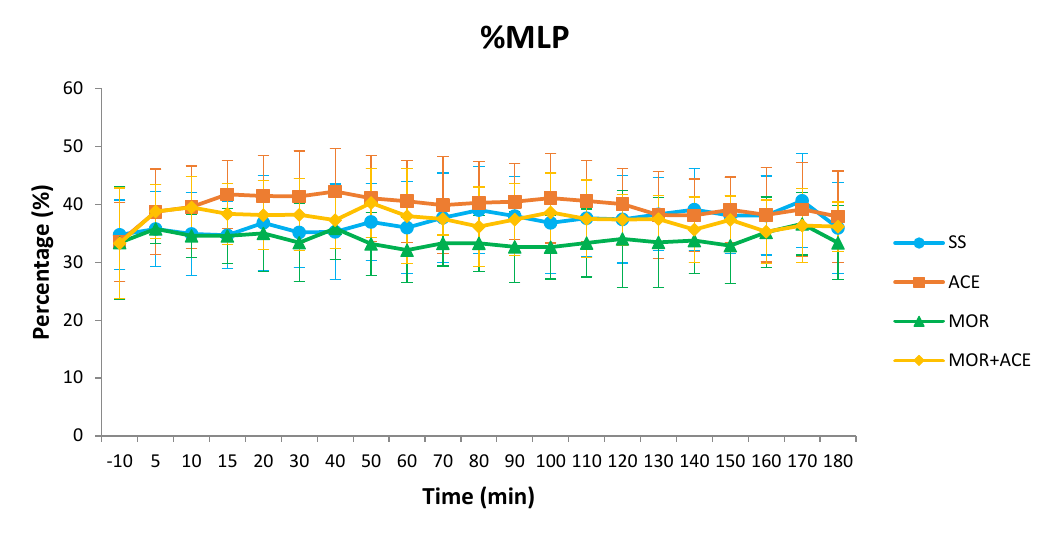
Figure 2. Mediolateral part of the power values (% ± SD) at baseline ( − 10 min) and at 5, 10, 15, 20, and then every 10 min (total period of 3 h) after IV injection (at 0 min) of 10 mL of sodium chloride (0.9%) (SS), 0.2 mg/kg of morphine hydrochloride solution diluted in sodium chloride (0.9%) to a volume of 10 mL (MOR), 0.02 mg/kg of acepromazine maleate diluted in sodium chloride (0.9%) to a volume of 10 mL (ACE), or a combination solution of 0.2 mg/kg of morphine hydrochloride and 0.02 mg/kg of acepromazine maleate diluted in sodium chloride (0.9%) to a volume of 10 mL (MOR + ACE).